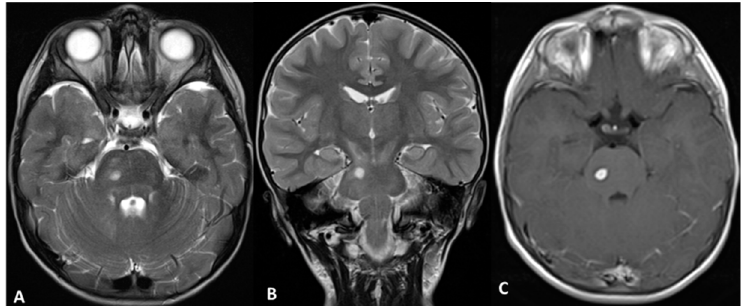
Figure 4. Brainstem Glioma (Subject 05 CT). ( A , B ) Axial and Coronal T2 weighted images (w.i.); ( C )